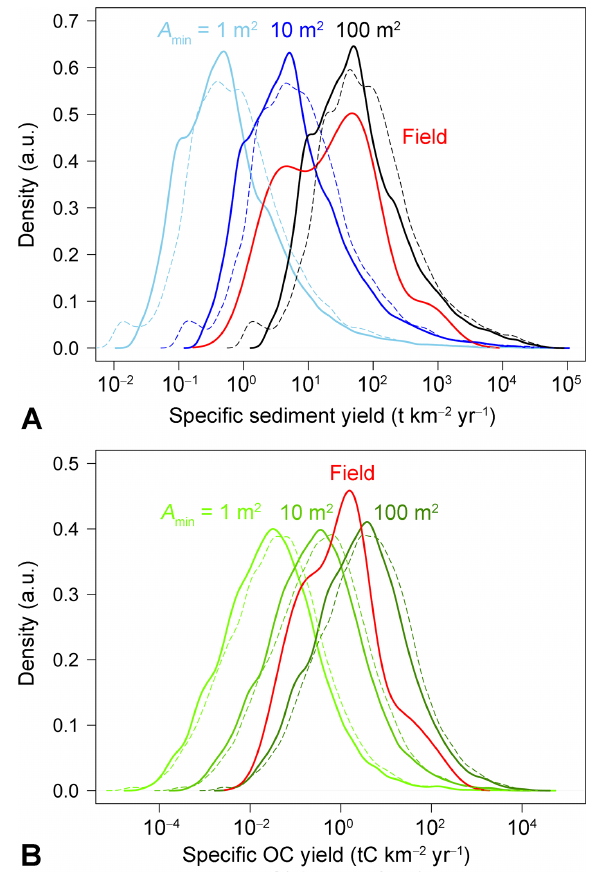
Fig. 4. Probability-density estimates of simulated and field-derived log 10 -transformed specific sediment and organic yields from wet snow avalanches in the area around Davos, eastern Swiss Alps. Simulations assumed power-law distributed avalanche-deposit ar- eas with varying arbitrary minimum debris-covered areas A min , and randomly sampled deposit thicknesses based on field measurements (each thick line represents one avalanche cone; dashed lines are pooled for all sites; see text for details). Thick red lines are esti- mates derived from linear interpolation of debris content measured from 1m 2 sample squares. More than 90% of the estimated sed- iment and carbon yields are spread over three and four orders of magnitude,